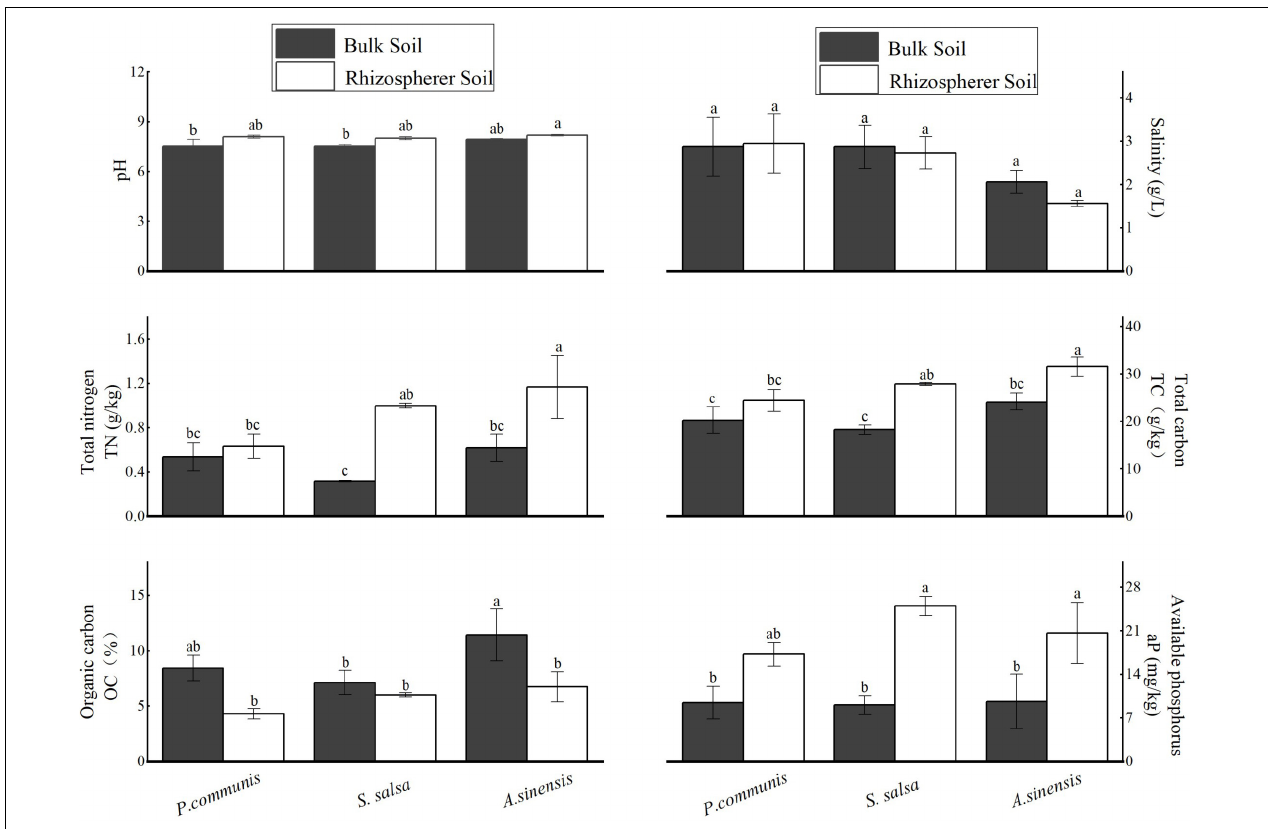
FIGURE 2 | Physicochemical factors in the rhizosphere and bulk soils of different halophytes. Different letters denote significant differences at P < 0.05.